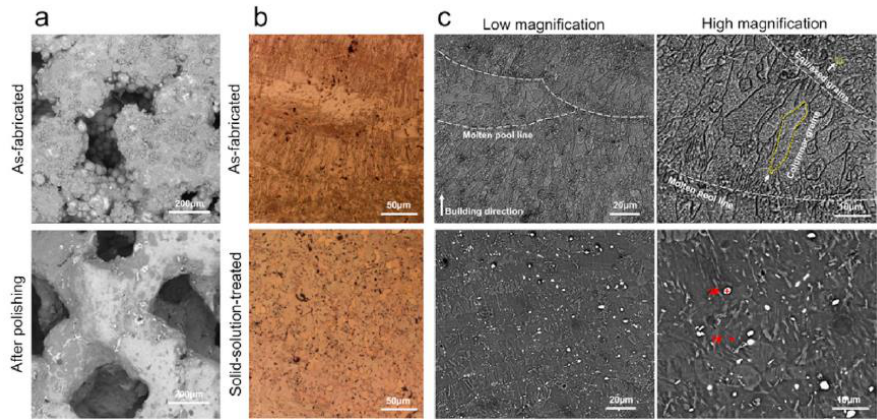
Figure 6. Characterization and degradation behavior of AM-manufactured JDBM scaffolds: ( a ) surface morphology; ( b ) optical microscopy images; ( c ) scanning electron microscopy images. Figure is licensed under CC − BY 4.0 [138].